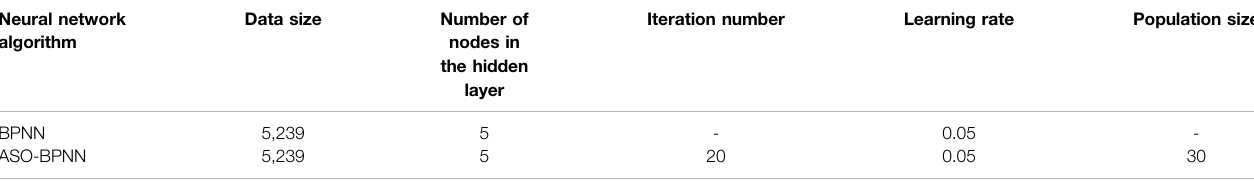
TABLE 2 | Parameter settings of each neural network algorithm. Neural network